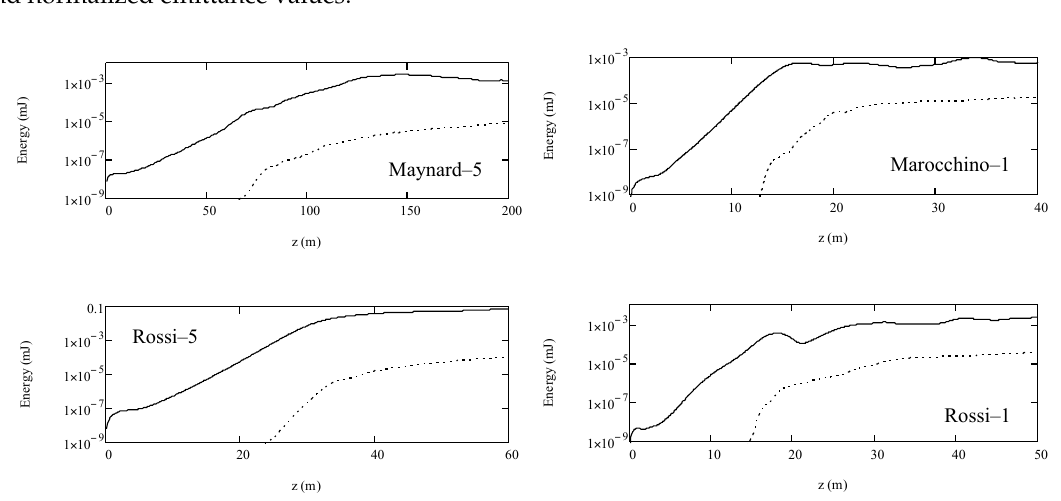
Figure 4. Growth of the SASE FEL energy per pulse of the specified beam distributions, for the fundamental (solid line) and third (dotted line)